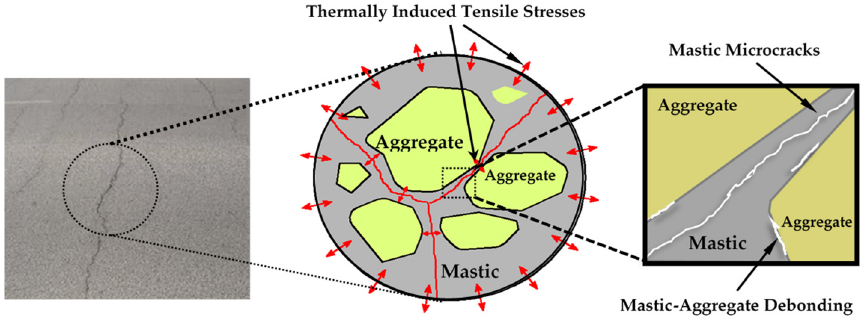
Figure 2. Schematic depiction of thermally-induced stresses within the asphalt mastic causing microcracks in the mastic and mastic-aggregate debondings.